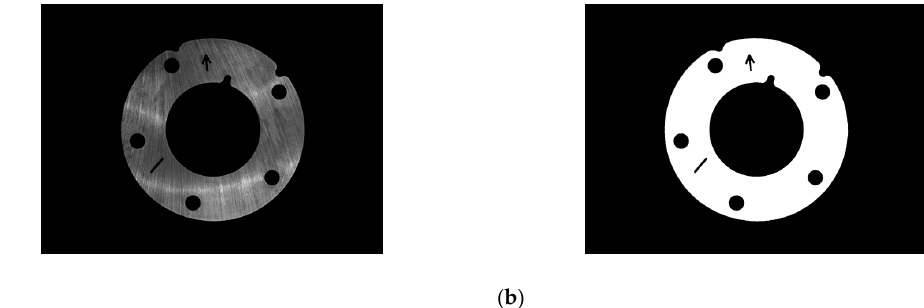
Figure 4. The region of interest for parts: ( a ) before segmentation; ( b ) after segmentation.